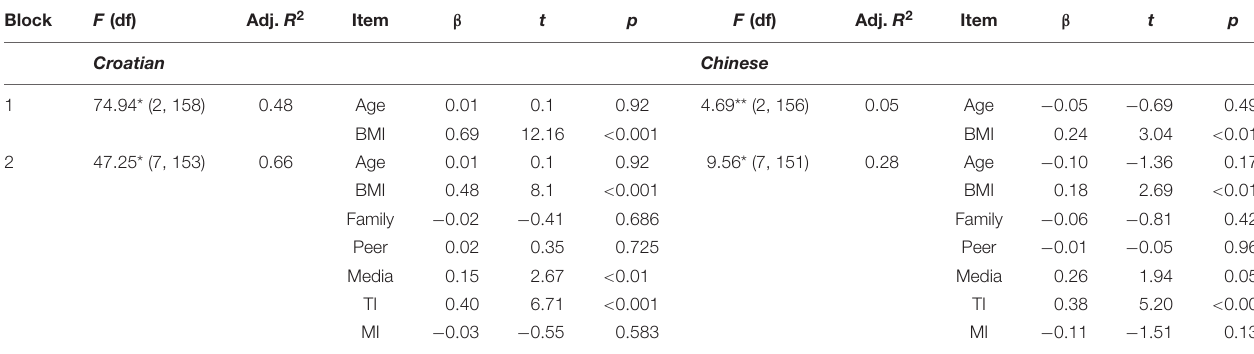
TABLE 4 | Multiple hierarchical regressions with body image dissatisfaction as assessed by CDRS scale as the dependent variable.